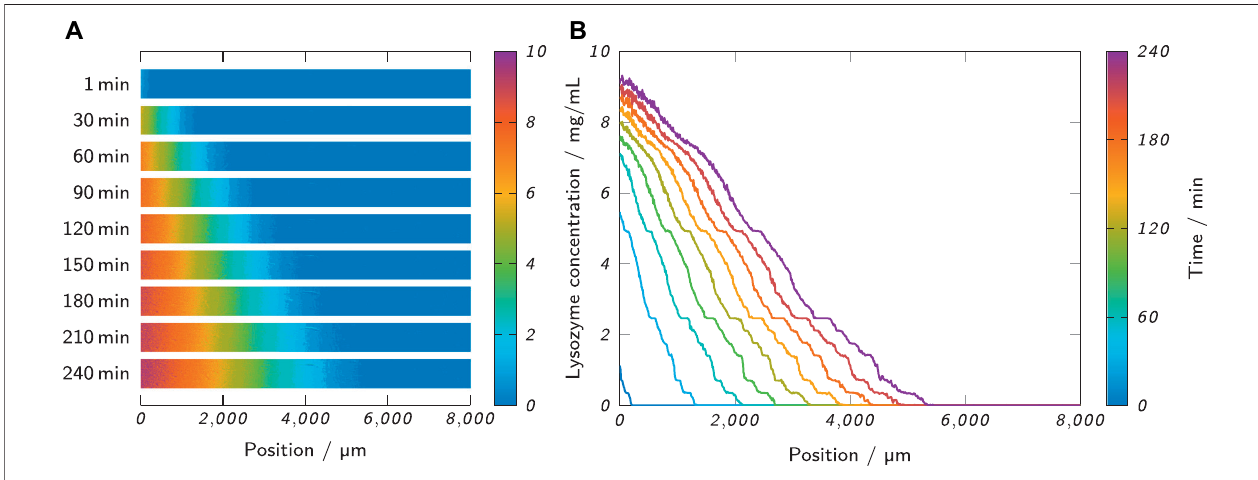
FIGURE 4 | (A) The observed analysis area of a measurement at different time points shows the propagation of the lysozyme through the hydrogel. (B) The lysozyme concentration pro fi les of the same measurement were obtained from the analysis area by column-wise calculation of mean values. The shown measurement was performed with 0.5% (w/w) low-melt agarose as the hydrogel and 10 mg/ml lysozyme as the analyte